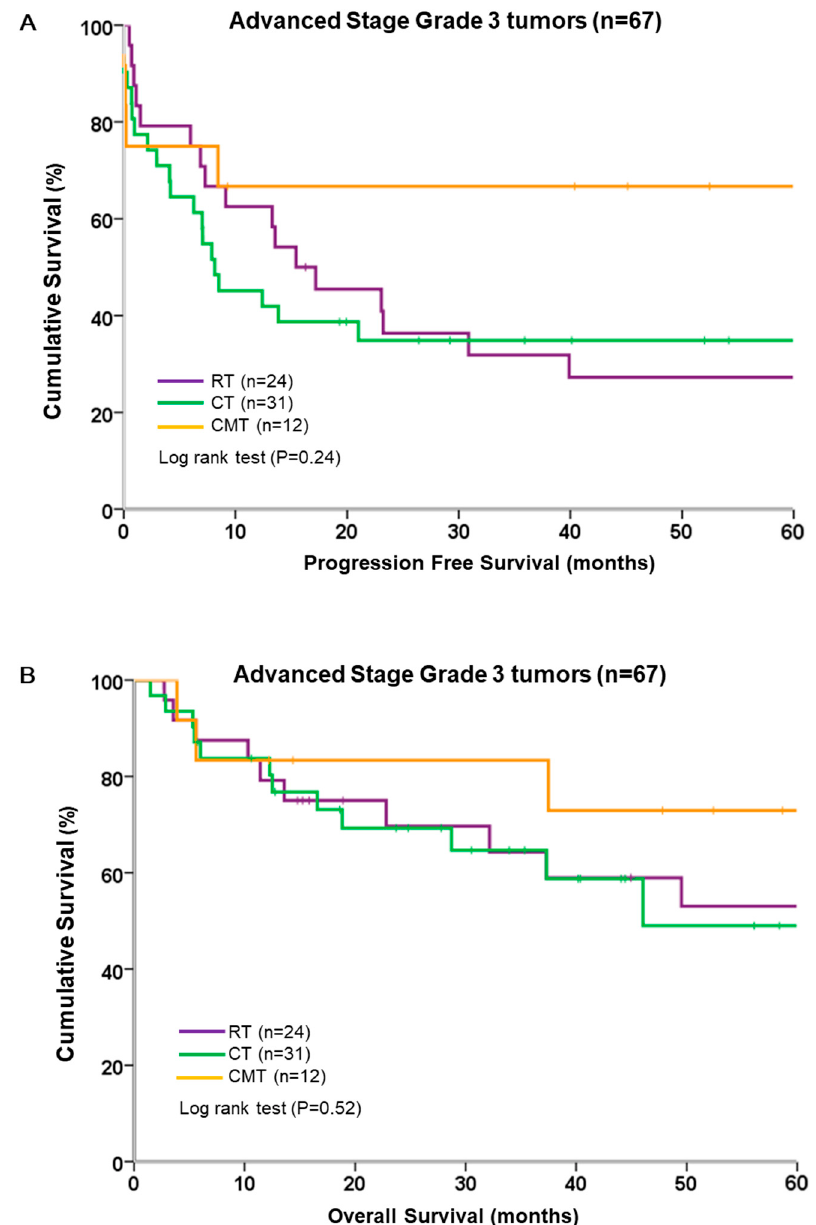
Figure 5. Survival of 67 patients with grade 3 tumors, stratified by different adjuvant modalities. ( A ) Progression-free survival; ( B ) overall survival.